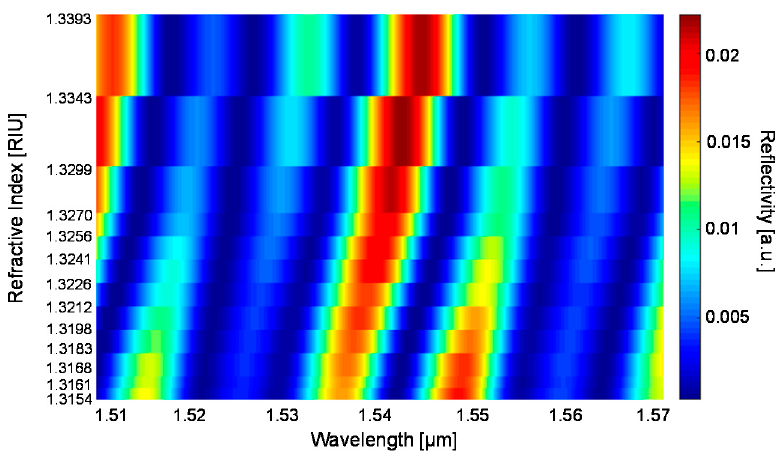
Figure 9. 2D view of a 3D reconstruction of the sequence of experimental spectra measured on a rectangular–miniature hollow glass tubing with d = 30 µm, t f = t b = 21 µm (nominal dimensions) filled with glucose-water solutions in 13 different glucose concentrations and thus 13 different RI values. Amplitude values are represented using false colours, indicated on the right side of the graph.